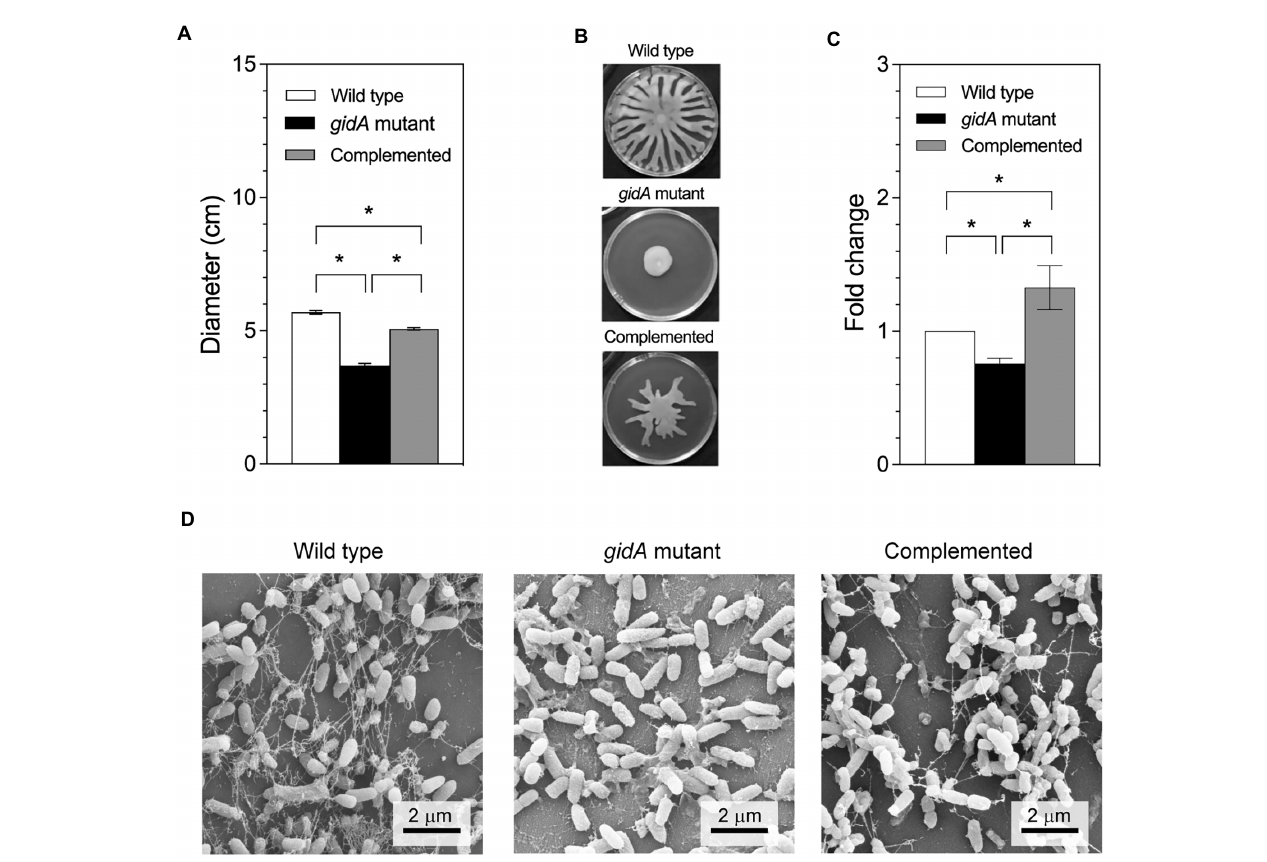
FIGURE 3 The gidA mutant strain shows defects in motility and biofilm production. (A) Swim colony diameter. Bacteria were stabbed into 0.3% BM2 medium agar. After incubation, the diameter of bacterial migration was measured from the stab point. (B) Images of the swarming plates. (C) The fold change in biofilm production for the wild-type, gidA mutant, and complemented strains using dye staining method. (D) Scanning electron microscope showing the biofilm formation. The images were recorded at magnification of 15,000x. The wild type and gidA mutant carried the pBBR1MCS-4 plasmid as a vector control. The data represent the mean ± SD values of three biological replicates for (A,C) . The statistical analysis was performed using Graphpad Prism (GraphPad Software). Asterisks denote a significant difference in the one-way ANOVA (* p ≤ 0.05).